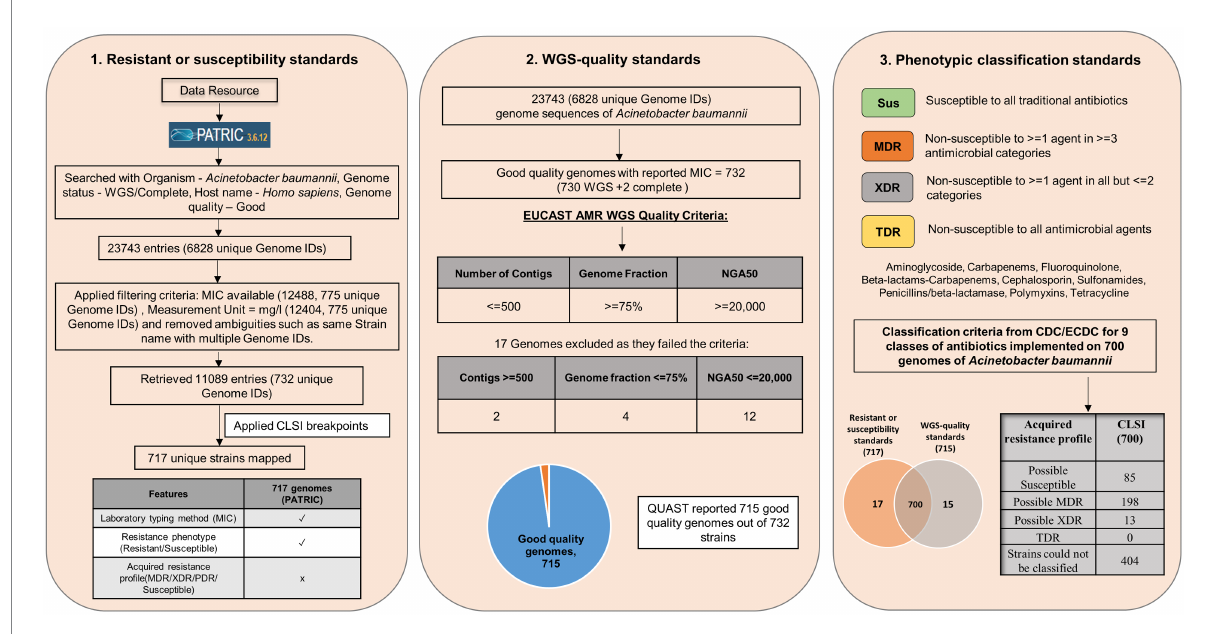
FIGURE 1 Schematic workflow of implementing global standards to WGS-inferred AST (resistant or susceptibility standards, WGS-quality standards, and Phenotypic classification